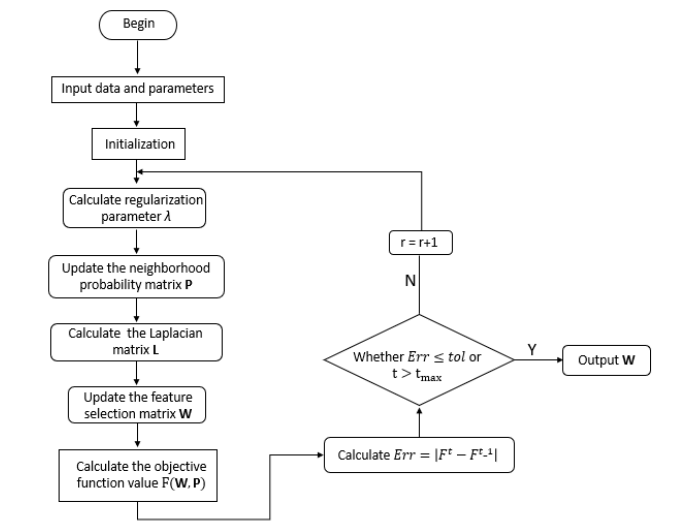
Figure 1. Block diagram of